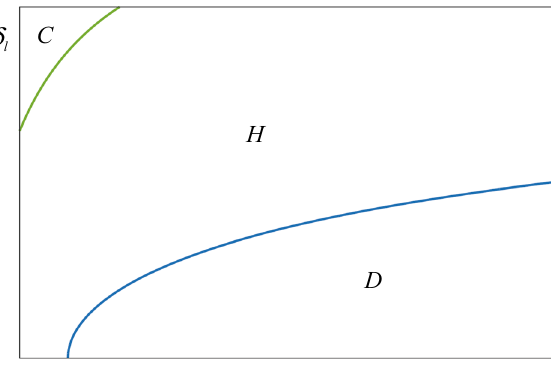
Fig. 6 Optimal institutional